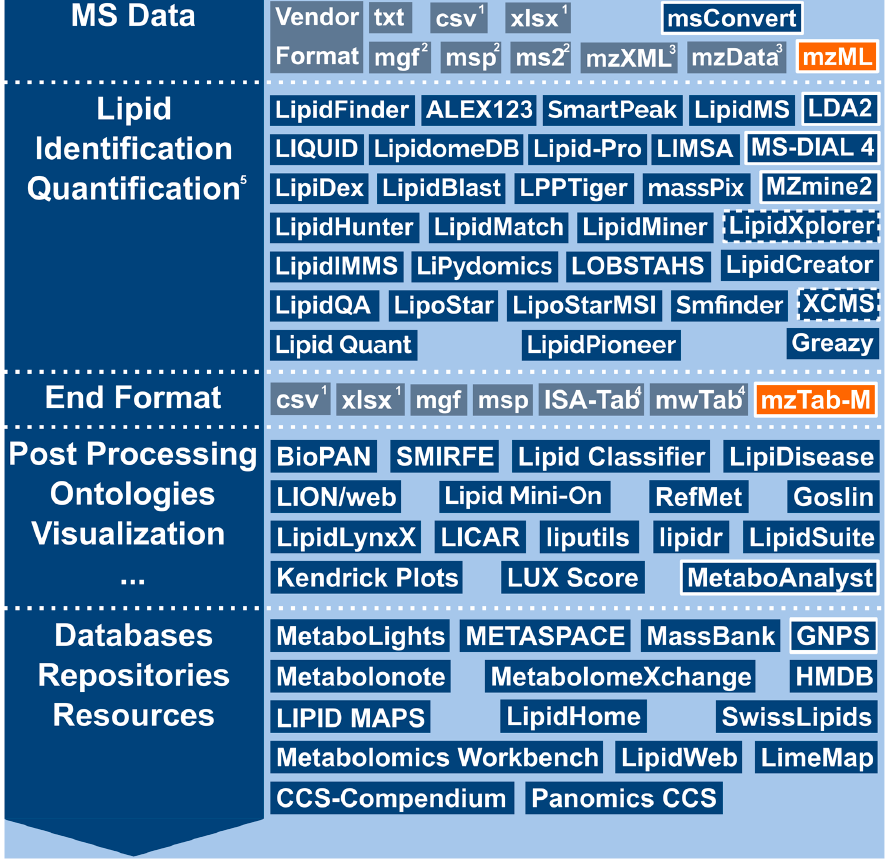
Figure 1. Data flow for different lipidomics software tools. From top to bottom, the supported ‘data format paths’ of selected lipidomics software tools that support at least one PSI standard data format are highlighted with a solid white outline. Those with planned or upcoming support are highlighted with a dashed white outline. The various software tools are represented by blue rectangles with the tool name in white. Data formats are represented by gray rectangles. On the right, the theoretically possible data flow between the PSI standard data formats, mzML and mzTab-M, is depicted (orange background) via supporting software and repositories/databases (white rectangle outline). In this figure, ‘Vendor Format’ stands for various proprietary, vendor-specific raw data formats (i.e., Thermo Fisher .raw, Agilent .d, ABSciex .wiff and Waters .raw), which can be converted to mzML (among other formats) using msConvert. (1) ‘csv/xlsx’ represents non-standardized output formats such as Microsoft XLSX, comma/tab separated text file formats and HTML. (2) ‘mgf/msp/ms2‘ are text- based formats that encode mass spectral data but generally do not have a strongly defined metadata schema. (3) ‘mzXML/mzData’ represent the legacy raw data and peak list formats mzXML and mzData. (4) ISA-Tab (used by MetaboLights) and mwTab (used by Metabolomics Workbench) are text-based, tabular data formats based on a defined metadata model, which simplifies validation and tooling. (5) Only some tools support quantification. See Table 1 for